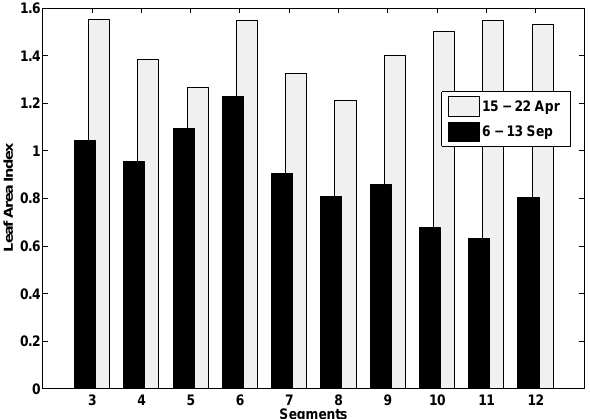
Table 3. Segment averages from airborne data along flight tracks during IOP1 (18–22April) at CERES’07.